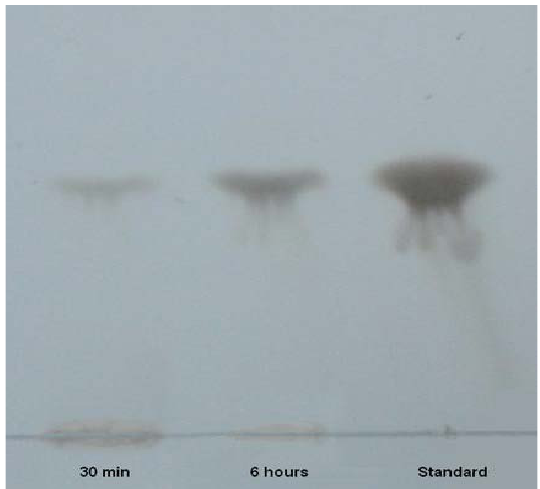
Figure 6. Thin layer chromatography of the reaction products of polygalacturonic acid hydrolyzed by PG. Hydrolysis times were 30 min and 6 h. Standard was 10 g/L of monogalacturonic acid.